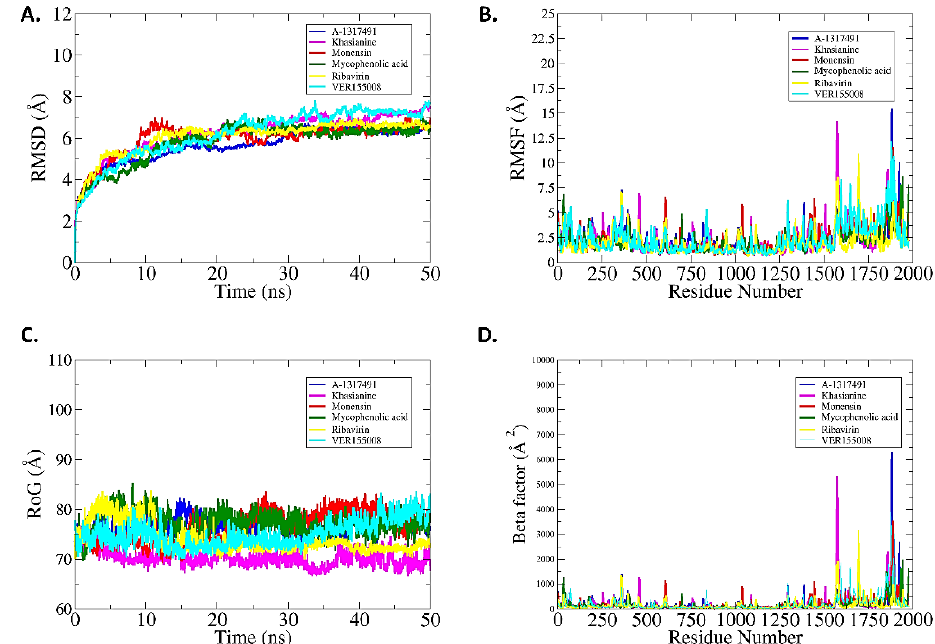
Figure 6. MD-Simulation studies of ligand bounded complexes. ( A ) Root mean square deviation. ( B ) Root mean square fluctuations (endoN domain 25–205 aa; PA-C-like domain 296–762 aa; RdRp core 763–1345 aa; PB2-N-like domain 1346–1571 aa; arm domain two spans 1615–1696 and 1811 aa; CBD domain 1697–1810 aa; and C-terminal domain 1933–2049 aa). ( C ) Radius of Gyrations. ( D ) Beta- factor analysis, each ligand is represented with different color such as A-1317491 (blue), Khasianane (pink), Monensin (Red), Mycophenolic acid (dark green), Ribavirin (Yellow), and Ver155008 (Cyan).